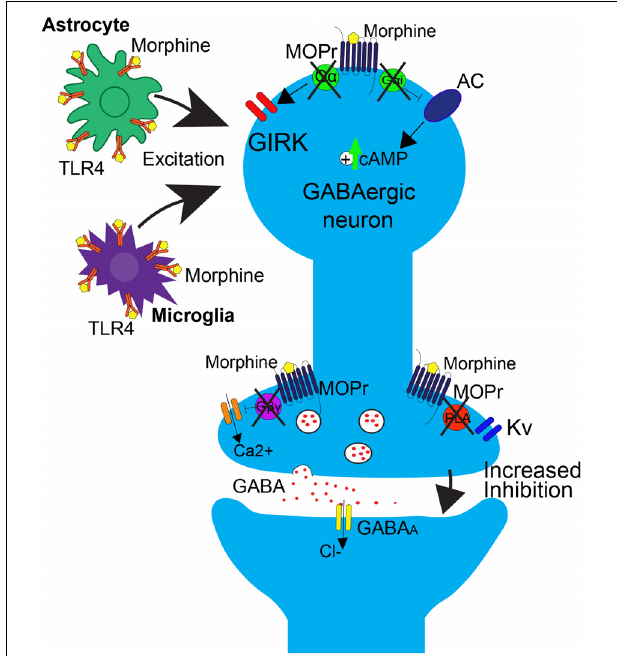
FIGURE 2 | Effects of repeated morphine treatment on glial and neuronal signaling in the PAG. Chronic morphine treatment induces several side effects that block opioid-induced decreases in GABAergic interneuron activity at the neuronal level, postsynaptically. This includes the uncoupling of MOPr from G-protein mediated effects on GIRK channels and AC. This results in an upregulation of cAMP. Uncoupling also occurs in the presynaptic region, blocking the G βγ mediated inhibition of calcium channels and PLA mediated activation of Kv channels. In this state, binding of opioids to MOPr no longer results in suppression of GABA release. At the level of glial signaling, upon repeated treatment with morphine, there is a rapid upregulation of TLR4 on astrocytes and microglia within the PAG, resulting in an increase in excitatory cytokine release, as well as a switch from G i / o to G s coupling at MOPr, resulting in an overall increase in excitatory tone that is correlated with opioid